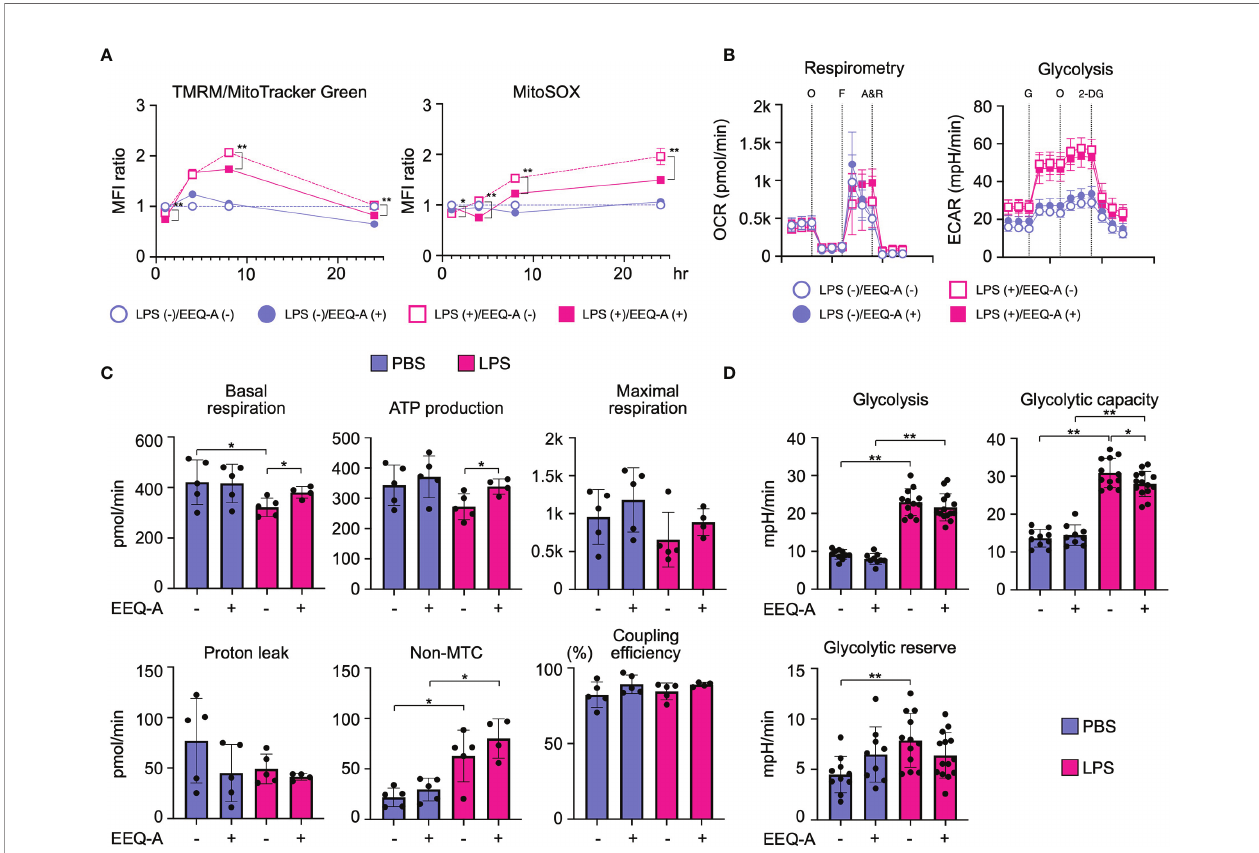
FIGURE 5 | (A) MFI of Dj and mtROS levels in THP-1 cells, the in fl ammation model, 1, 4, 8, and 24 hours after LPS administration. All data were evaluated using unpaired t test only between closed and open circles or squares. (B) Changes in the OCR and ECAR of in fl ammation model THP-1 cells 24 hours after LPS administration, as measured using fl ux analysis. O: oligomycin, F: FCCP, A&R: antimycin and rotenone, G: glucose, 2-DG: 2-deoxy-D-glucose. (C) Each index of mitochondrial respiratory function was calculated from the results of the OCR measurement. (D) Each index of glycolysis was calculated from the results of the ECAR measurement. **: < 0.0001, *: 0.0001 to 0.05. All experiments were